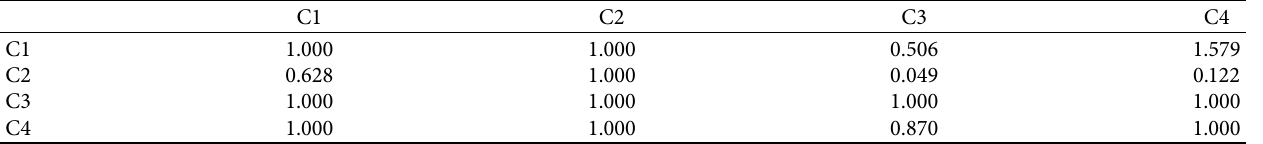
Table 8: Fuzzy-AHP priority vector ( V )